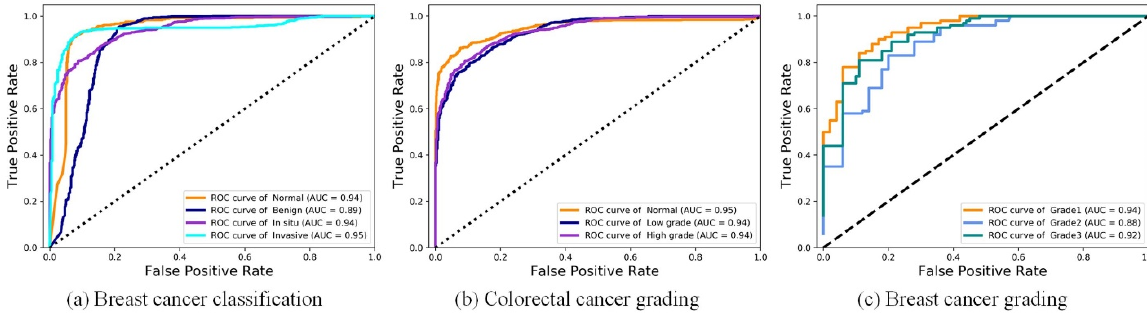
Figure 6. Visualization of ROC on three datasets.